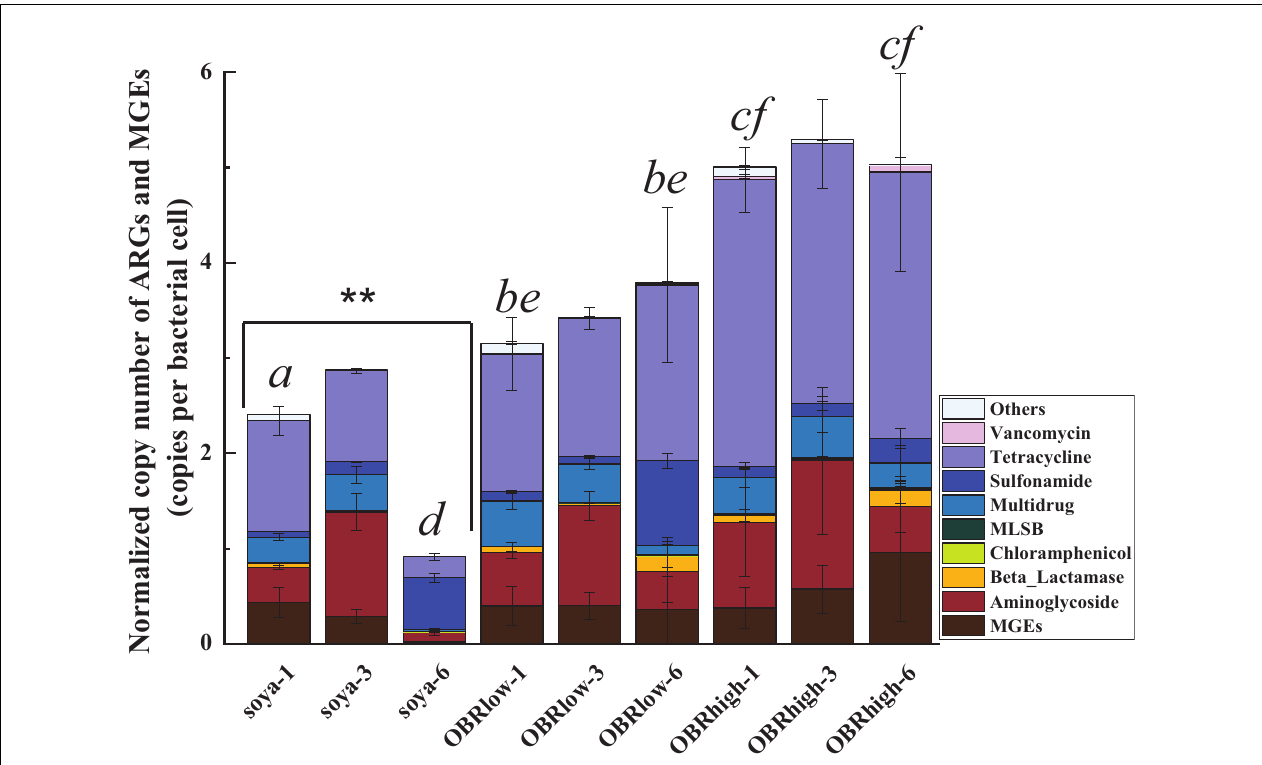
FIGURE 6 | Abundance of ARGs and MGEs in the guts of larvae. Normalized copy numbers of ARGs and MGEs (mean ± SE, n = 3). “ ∗∗ ” indicates P < 0.01 (among soya groups). Different letters indicate significant differences ( P < 0.05, soya-1 vs. OBRlow-1 vs. OBRhigh-1, and soya-6 vs. OBRlow-6 vs. OBRhigh-6). The soya, OBRlow and OBRhigh represent treatments containing only soybean meal, a low amount of OBR and a high amount of OBR, respectively, 1, 3, and 6 represent the first, third, and sixth day,